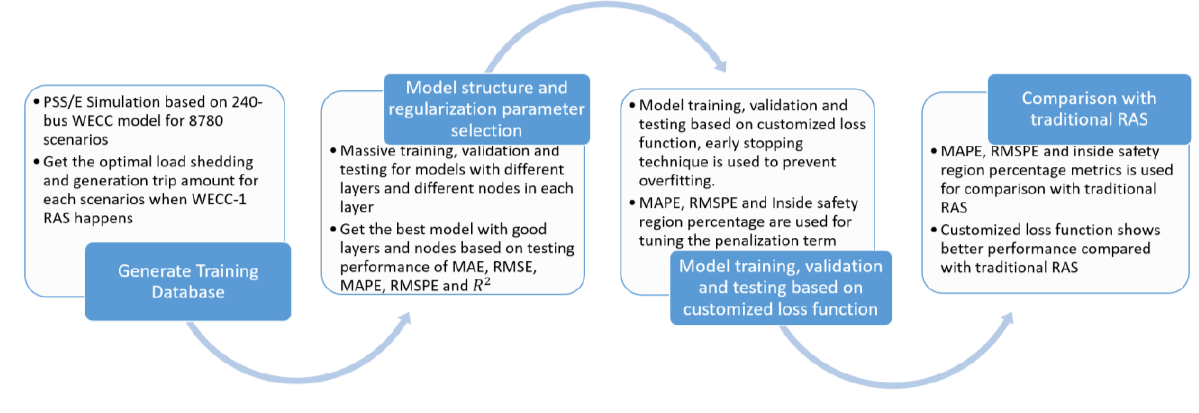
Figure 1. Flow chart of process.